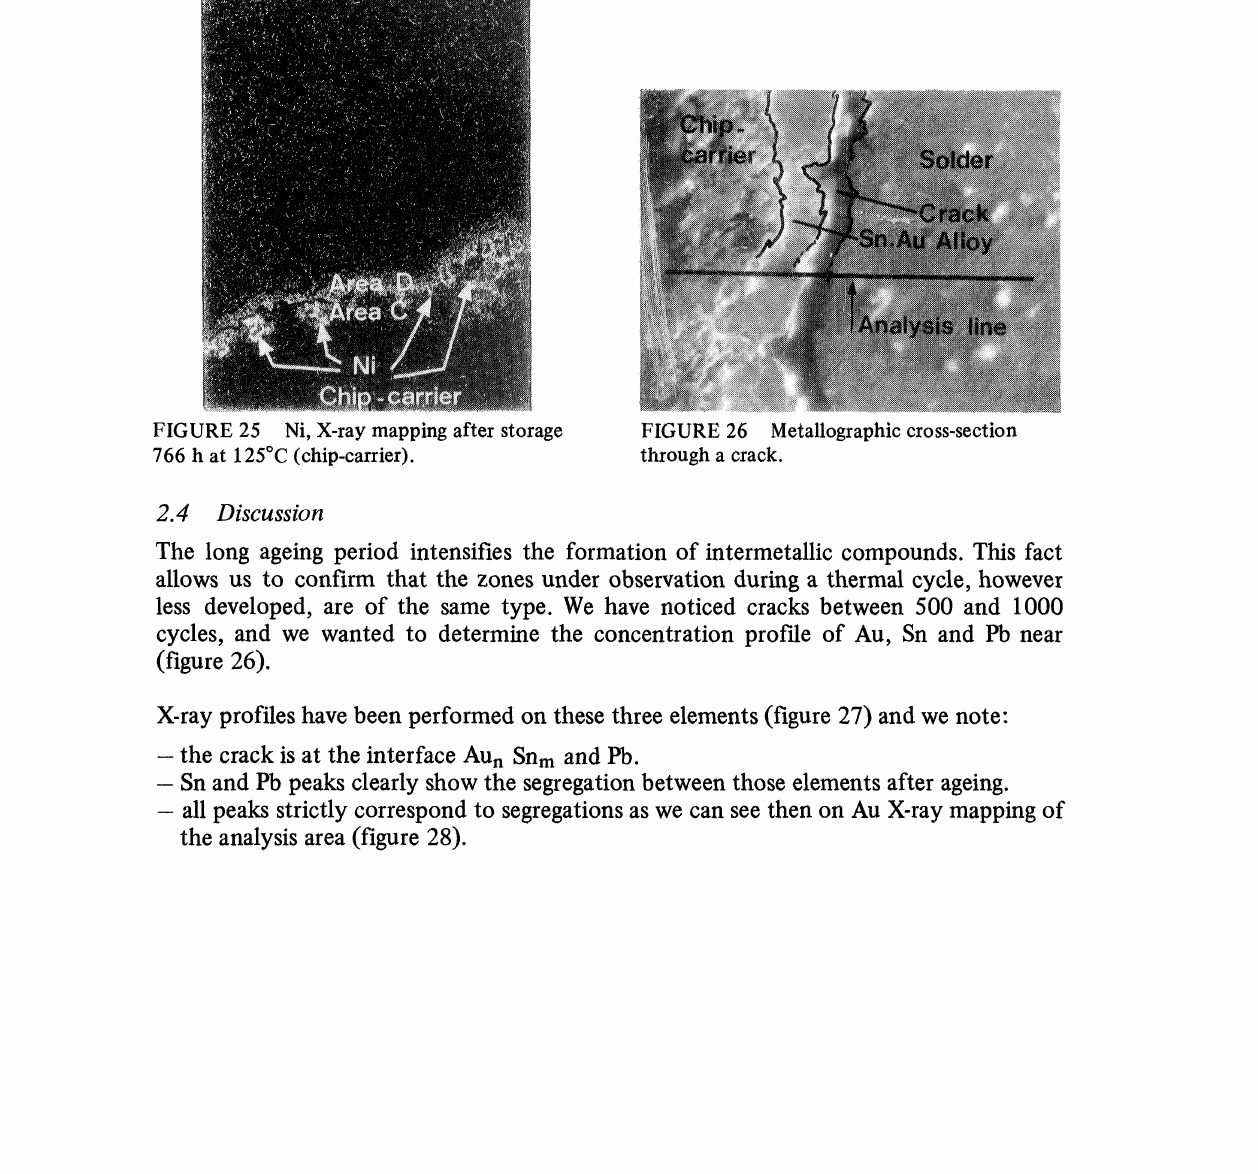
FIGURE 24 Au, X-ray mapping after storage 766 h at 1250C (chip-carrier).